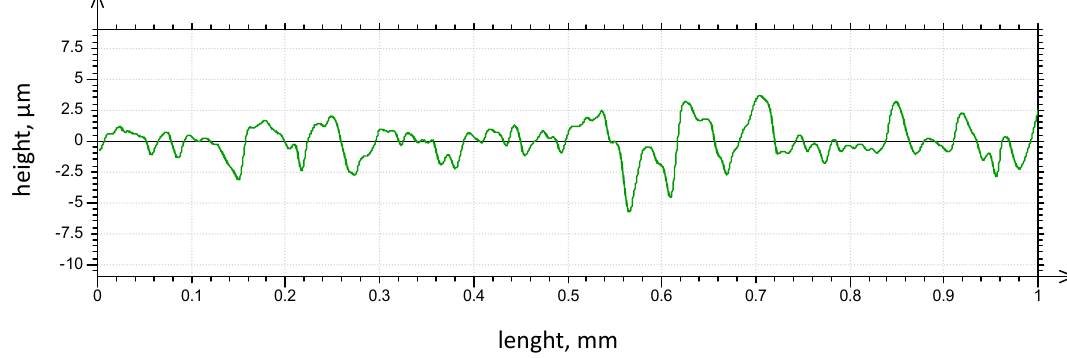
Figure 6. The surface profiles of the specimen.